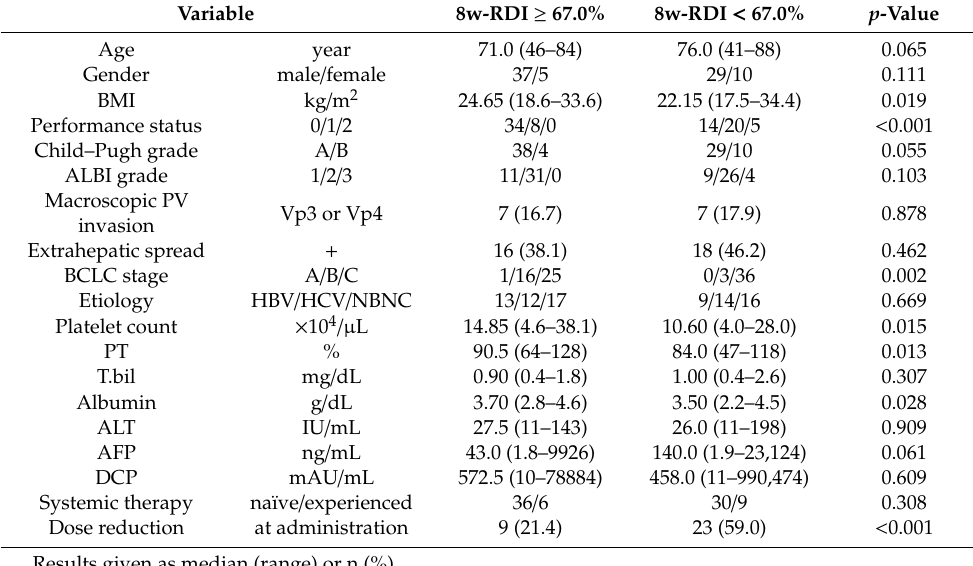
Table 5. Comparison between two groups with relative dose intensity.